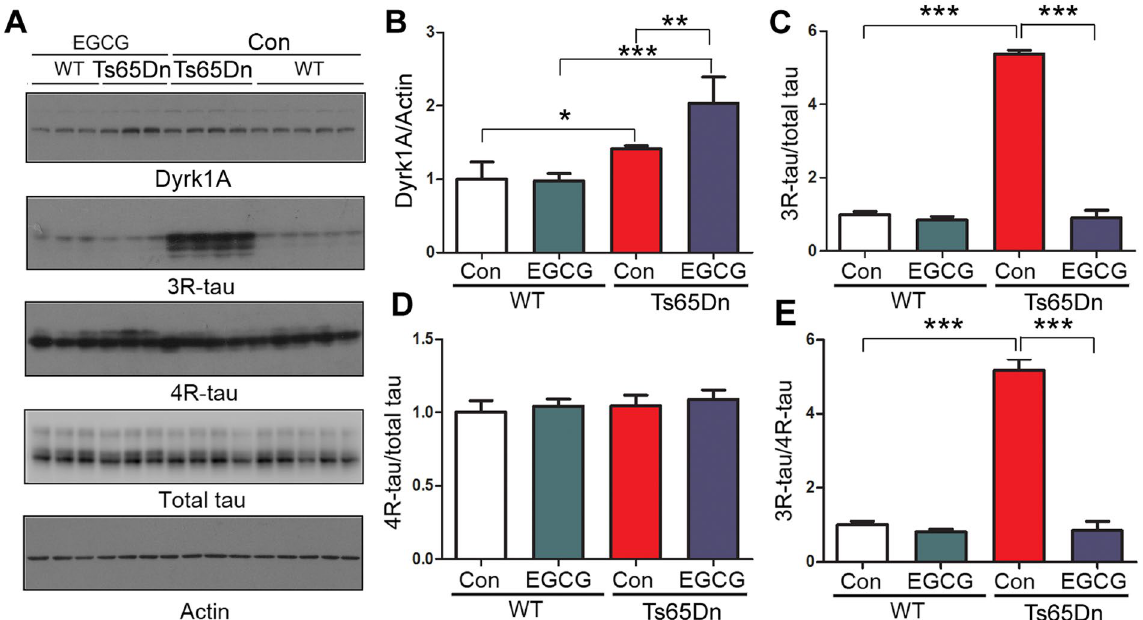
Figure 6. EGCG suppresses the increased 3R-tau expression in Ts65Dn mice. Ts65Dn or control mice were treated with EGCG from mating to adulthood. The 3R-tau, 4R-tau and total tau in the forebrains from 5 month old mice were analyzed by Western blots ( A ). The level of Dyrk1A ( B ), 3R-tau ( C ), 4R-tau ( D ) and ratio of 3R-tau/4R-tau ( E ) are presented as mean ± S.D. (n = 3–5) and analyzed by two way ANOVA followed post-hot